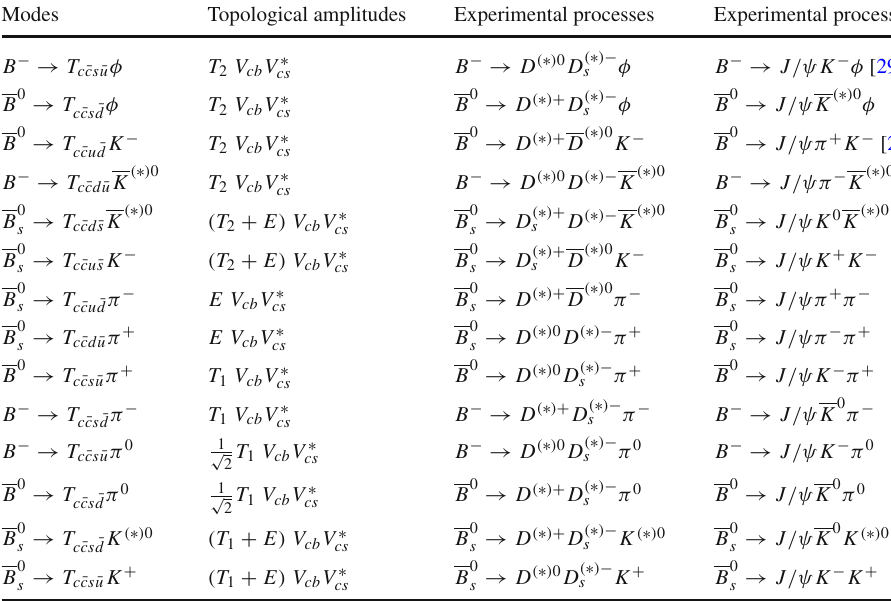
Modes Topological amplitudes Experimental processes Experimental of the B meson decaying into one hidden-charm open-flavor tetraquark and a meson